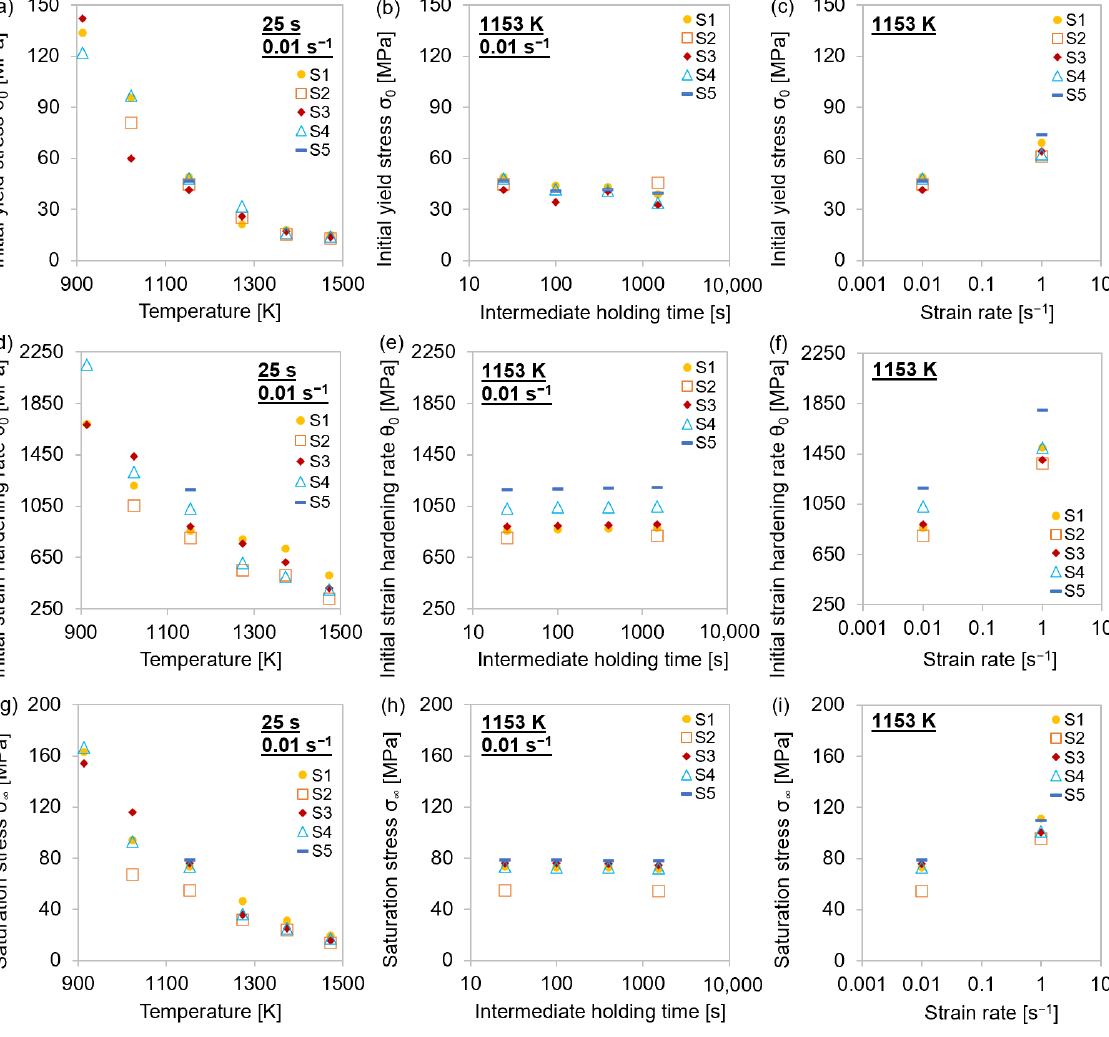
Figure 7. Physical parameters for single-hit compression tests with 25–1500 s holding times before deformation and 0.01–1 s − 1 strain rates at 913–1473 K for MA steel grades S1–S5. ( a – c ) Initial yield stress σ 0 ; ( d – f ) initial strain hardening rate θ 0 ; ( g – i ) saturation stress σ ∞ .